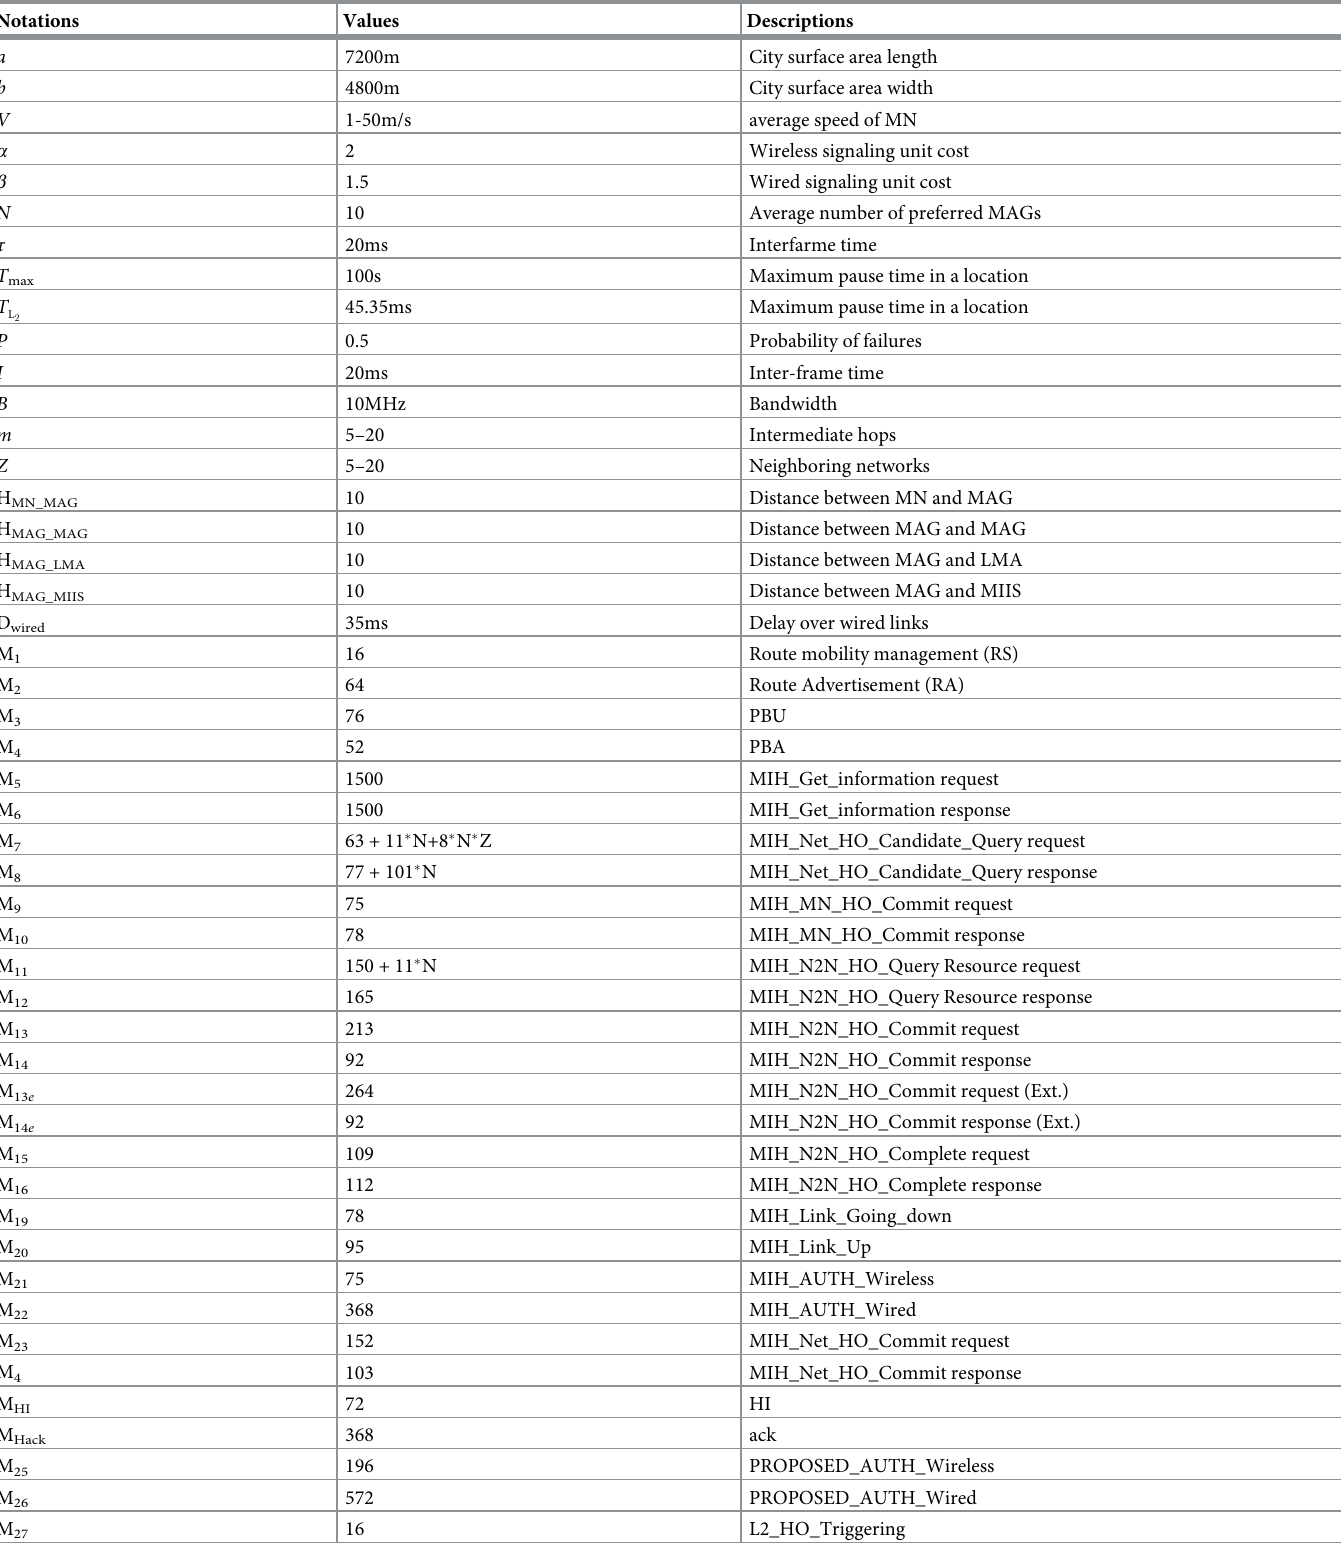
Table 3. Parameters list and corresponding